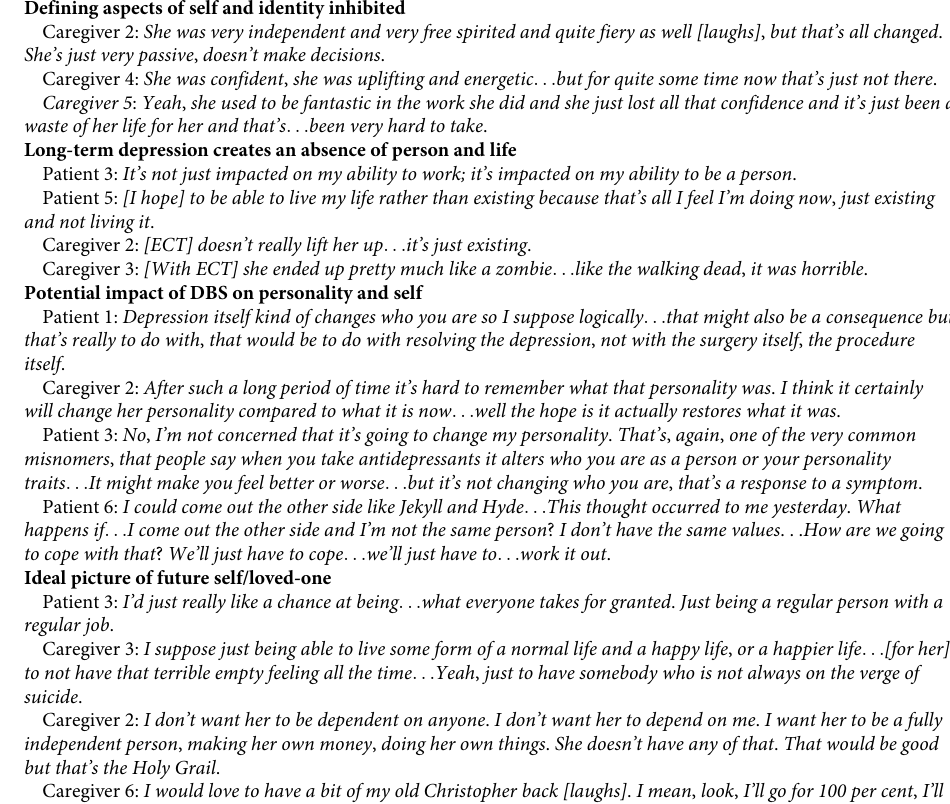
Table 1. Impact of mental illness and treatment on self-concept–Pre-DBS. Defining aspects of self and identity inhibited Caregiver 2: She was very independent and very free spirited and quite fiery as well [laughs] , but that’s all changed . She’s just very passive , doesn’t make decisions . Caregiver 4: She was confident , she was uplifting and energetic ... but for quite some time now that’s just not there . Caregiver 5 : Yeah , she used to be fantastic in the work she did and she just lost all that confidence and it’s just been a waste of her life for her and that’s ... been very hard to take . Long-term depression creates an absence of person and life Patient 3: It’s not just impacted on my ability to work; it’s impacted on my ability to be a person . Patient 5: [I hope] to be able to live my life rather than existing because that’s all I feel I’m doing now , just existing and not living it